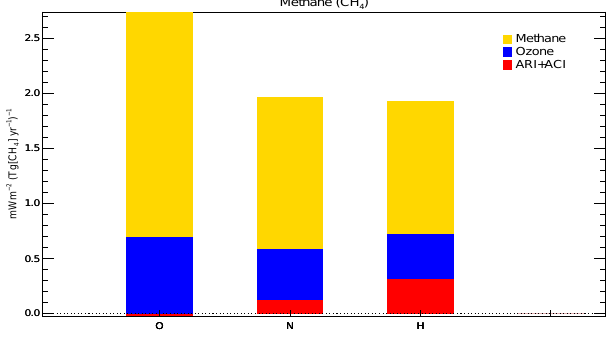
Figure 3. Specific radiative forcing, in mWm − 2 (Tg[CH 4 ]yr − 1 ) − 1 , for global and annual reductions in equivalent methane emissions (see Sect. 3.2 for details). Results are obtained by three global models: OsloCTM2 (O), NorESM1 (N), and HadGEM3 (H). Three categories of radiative forcing mechanisms are included: aerosol–radiation and aerosol–cloud interactions (red), short-term changes in ozone (blue), and methane